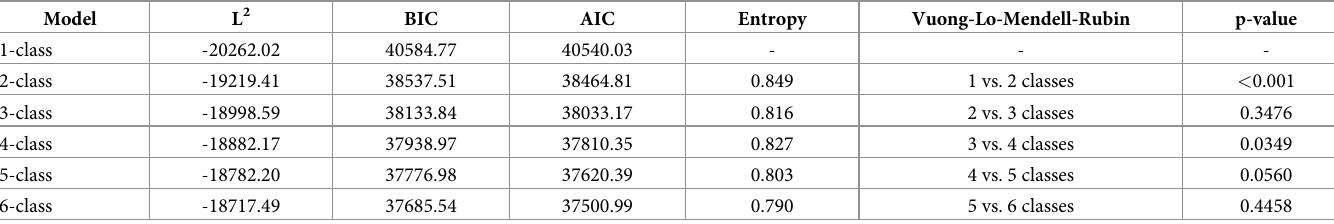
Table 3. Model fit indices for latent classes of depressive symptoms from pregnancy to one year postpartum.